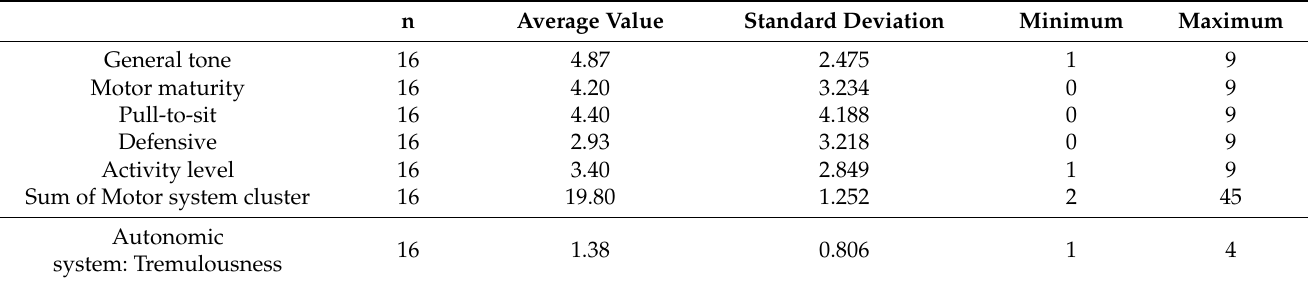
Table 1. Motor system cluster and ANS cluster from the NBAS.